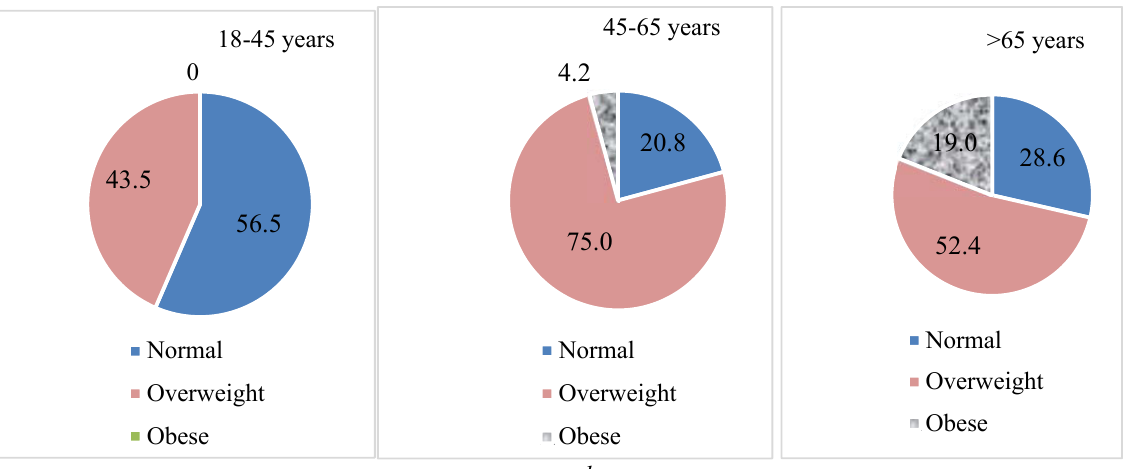
Fig. 2. Body mass index among males (n=107), p=0.000: a – body mass index in the 18-45 years old group; b – body mass index in the 45-65 years old group; c – body mass index in the group above 65